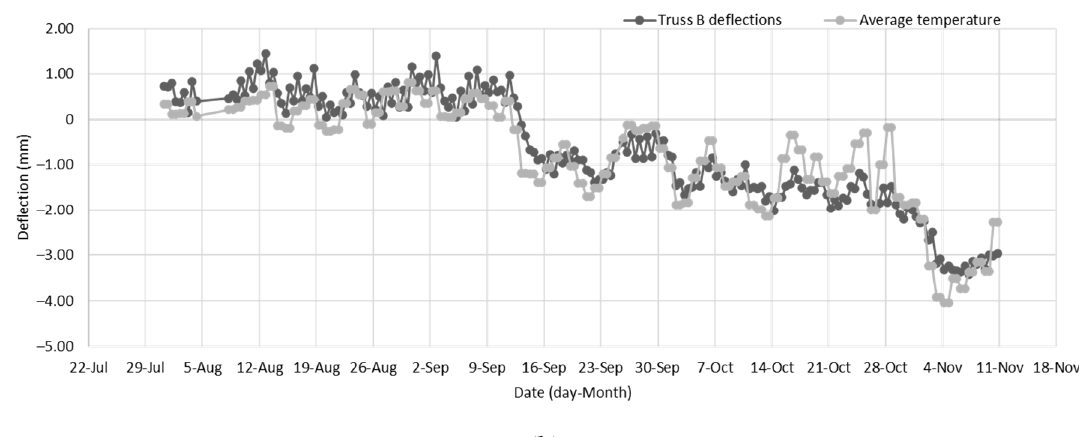
Figure 9. The average temperatures time series were scaled and biased to match the deflection observations’ range, where ( a ) shows Truss A deflections compared to twice-a-day temperature measurement; and ( b ) shows Truss B deflections compared